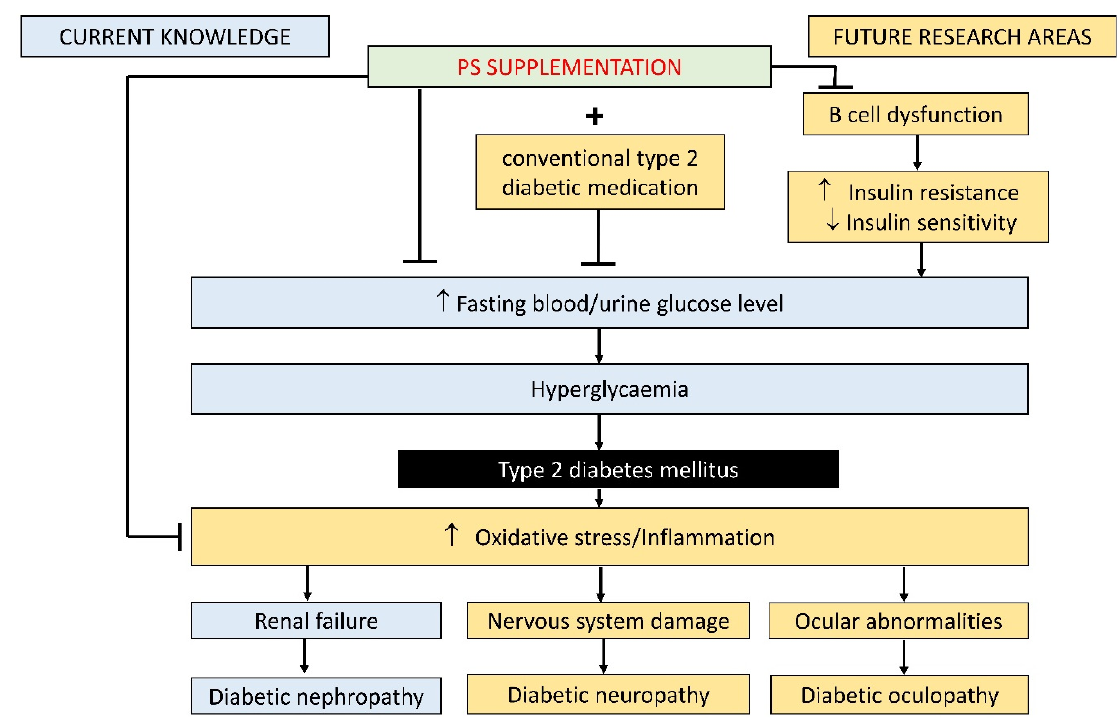
Figure 3. Protective effect of PS supplementation against hyperglycaemia and T2DM: current knowledge and future area of investigation. List of abbreviation s : PS, Piper sarmentosum ; ↑ , increase; ↓ , decrease; +, in combination with.